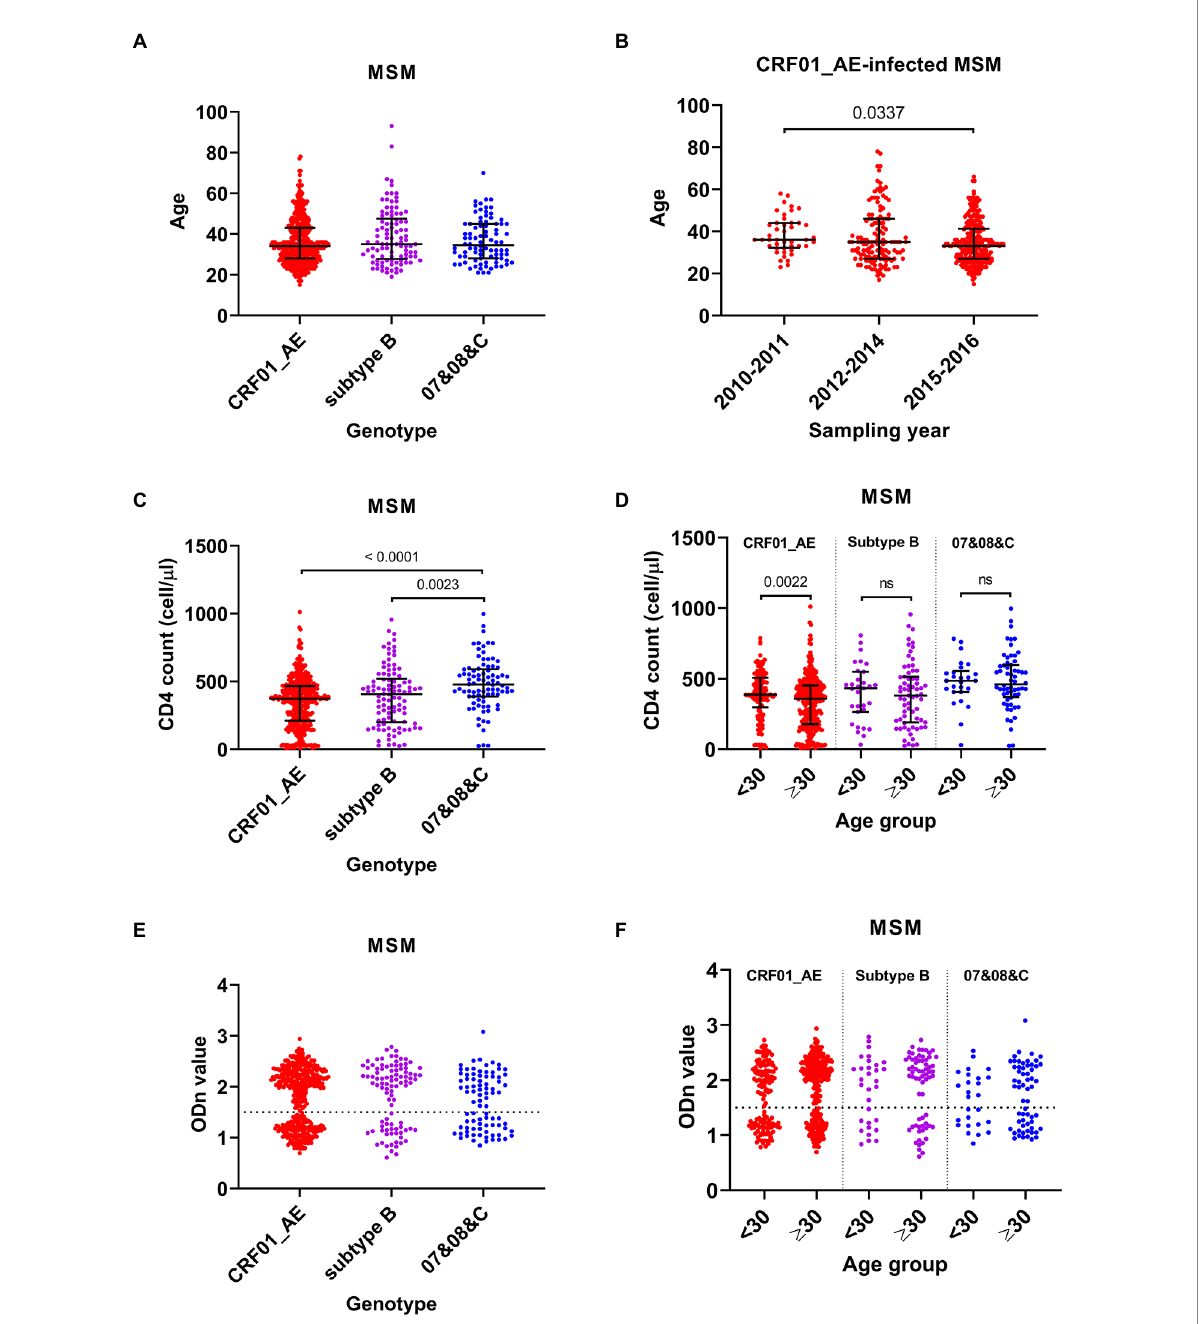
FIGURE 3 Comparison analyses among men who have sex with men (MSM) infected by different HIV-1 genotypes. (A) The age of MSM infected by different genotypes. (B) The age of CRF01_AE-infected MSM in three sampling times. (C) The CD4 cell count of MSM infected by CRF01_AE, subtype B, and 07&08&C viruses. (D) The CD4 cell count of cases aged <30 years and aged ≥ 30 years with different HIV-1 genotype infection. (E) The normalized optical density (ODn) value of plasma samples from MSM infected by different genotypes in Limiting-Antigen Avidity assays. (F) The ODn value of plasma samples from MSM aged <30 years and aged ≥ 30 years with different HIV-1 genotype infection. Data in (A–D) were shown as median with interquartile range, and the comparison across groups was done by Kruskal–Wallis test. 07&08&C, virus that had a genotype of